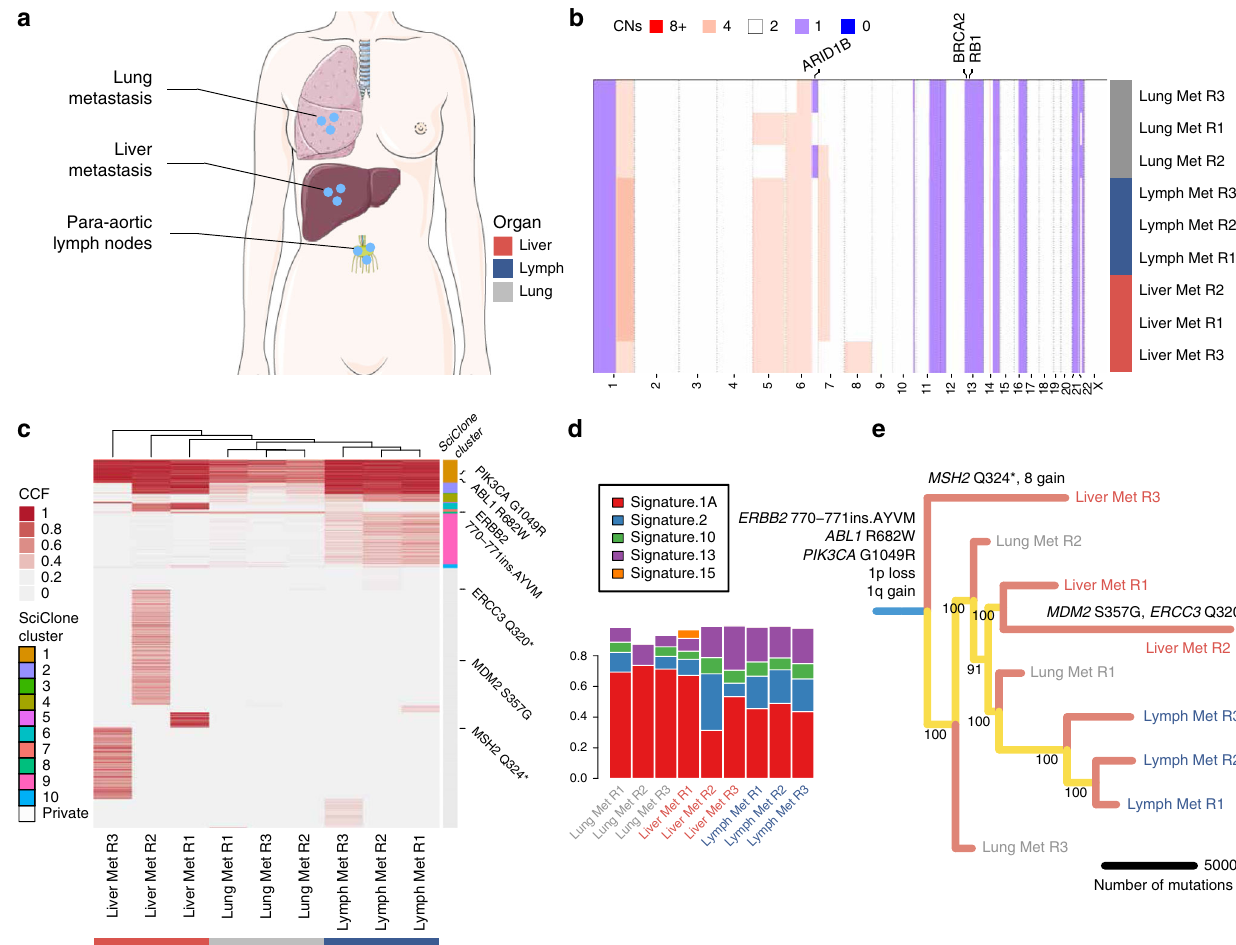
Fig. 3 Genomic pro fi ling and clonal evolution analysis of LEGACY patient 2. a Multiple samples from distinct metastatic deposits in different organs were collected from this patient, together with blood germline reference (buffy coat) and plasma. b Copy number alterations analysis highlights largely homogeneous copy number pro fi les. c Single-nucleotide variants analysis identi fi ed clonal PIK3CA and ERBB2 putative driver mutations and multiple subclonal truncating mutations in DNA repair genes that seem to be responsible for the higher number of private mutations in Liver Met R2 and R3. d Mutational signature analysis highlights aging (signature 1A) but also APOBEC (signatures 2 and 13) as dominant mutational processes. e Clone tree shows early divergence for liver and lung metastases but largely monoclonal seeding of all